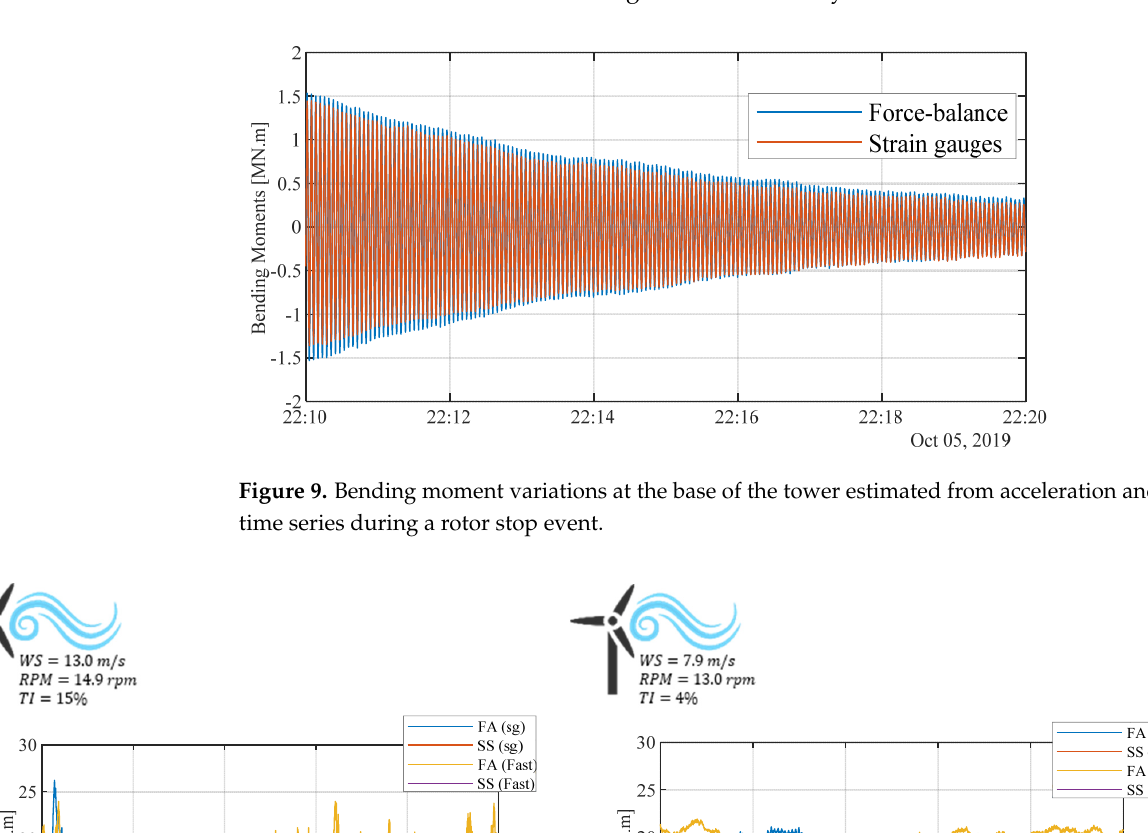
Figure 9. Bending moment variations at the base of the tower estimated from acceleration and strain time series during a rotor stop event.